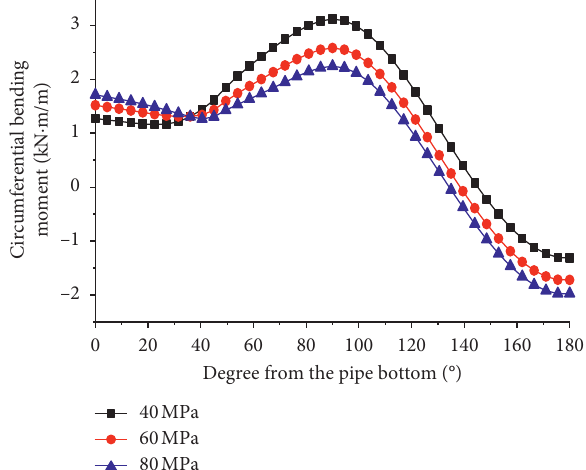
Figure 14: Radial deformation with different loads.